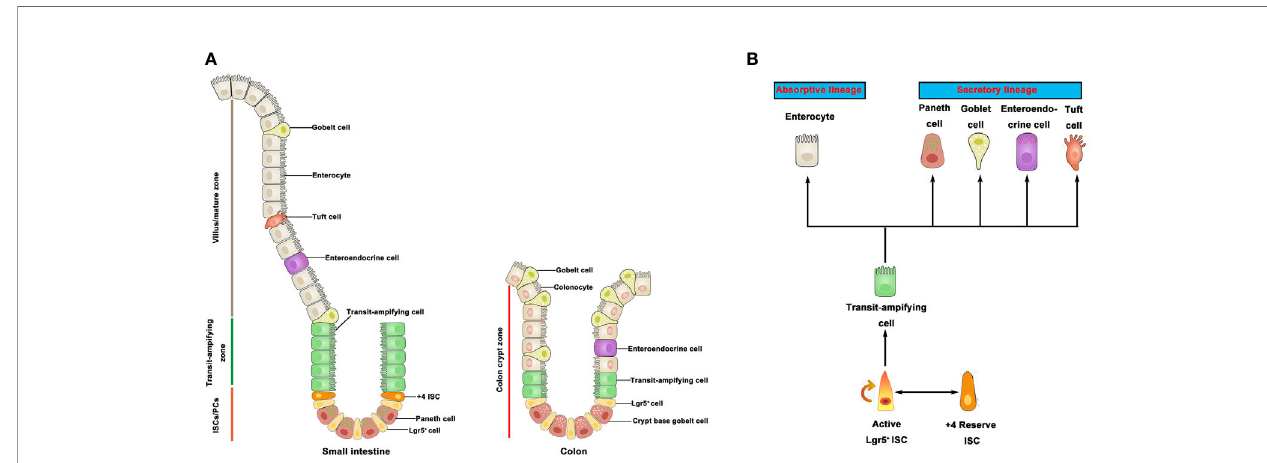
FIGURE 1 | Intestinal stem cells and differentiated progeny. (A) The intestinal epithelium is covered with a monolayer of epithelial cells. ISC generate TA cells in the crypts. TA cells migrate upward along the villi-crypt axis and differentiate into various epithelial cells. ISC are located at the bottom of the intestinal crypts. (B) Lgr5 + ISC generate TA cells, which can produce two mature epithelial cell lineages: absorptive type (enterocytes) and secretory type (goblet cells, Paneth cells, tuft cells, and enteroendocrines). +4 ISC have been proposed as a quiescent stem cell population. ISC, intestinal stem cell; TA,